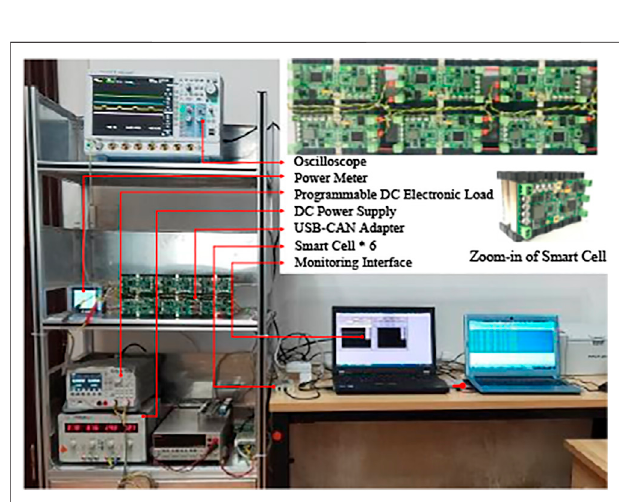
FIGURE 3 | Photograph of the experimental